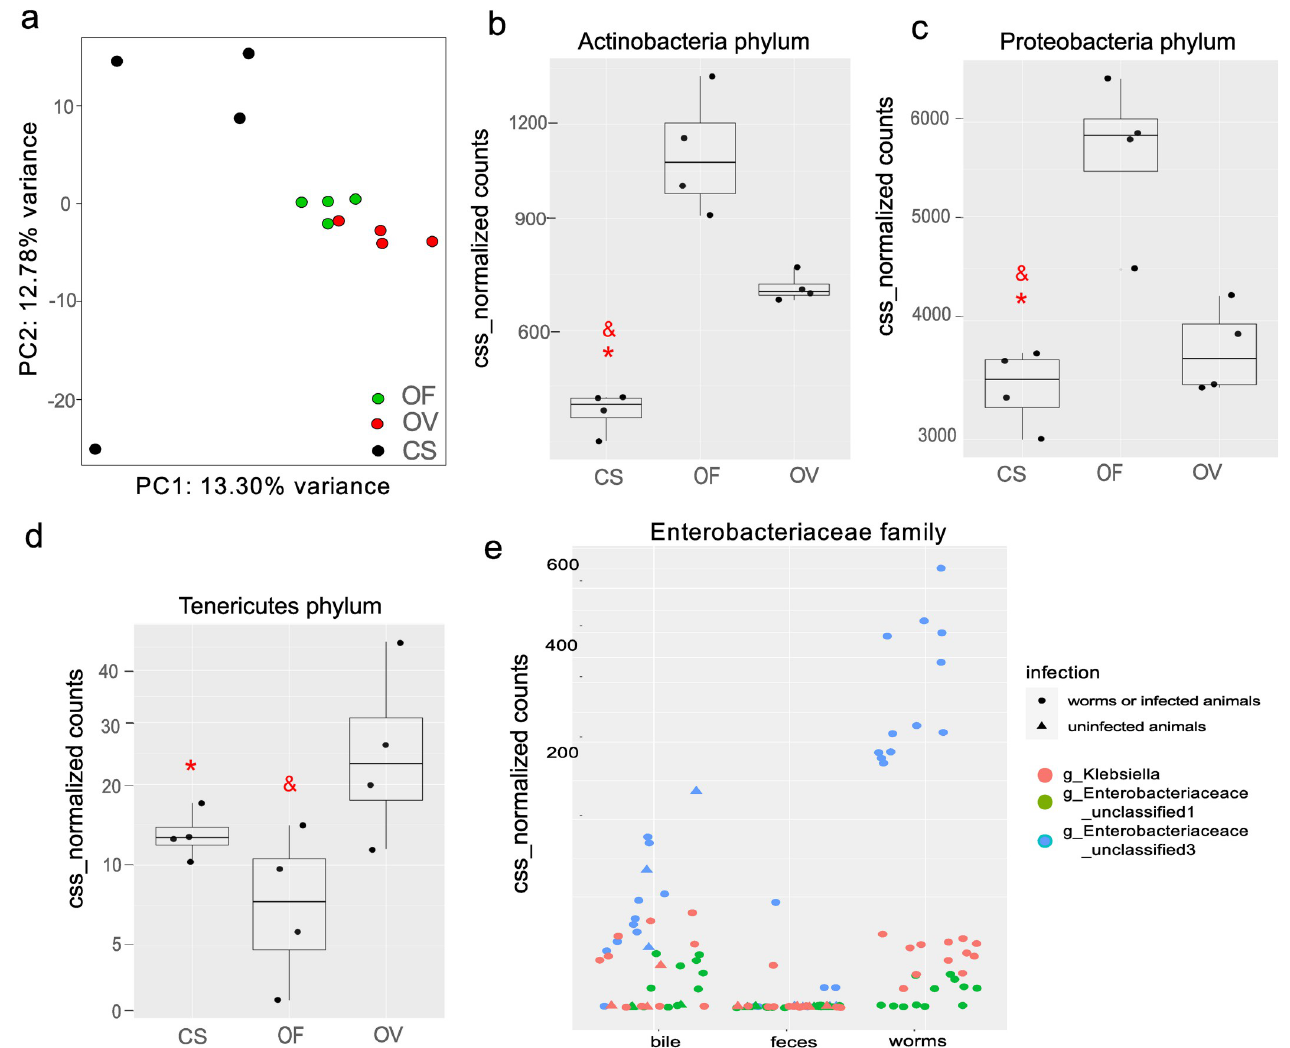
Fig 7. Results of alpha and beta diversity analyses of the worm samples. a. Beta diversity. Weighed UniFrac analysis (pseudo-F = 1.3613, P = 0.002). b–d. Differently distributed phyla among worm samples. e. Worm samples are enriched with Enterobacteriaceae bacteria. � False Discovery Rate < 0.05, significant differences from the O . felineus samples, & False Discovery Rate < 0.05, significant differences from the O . viverrini samples (Wilcoxon’s test of CSS-normalized counts with the Benjamini–Hochberg correction).